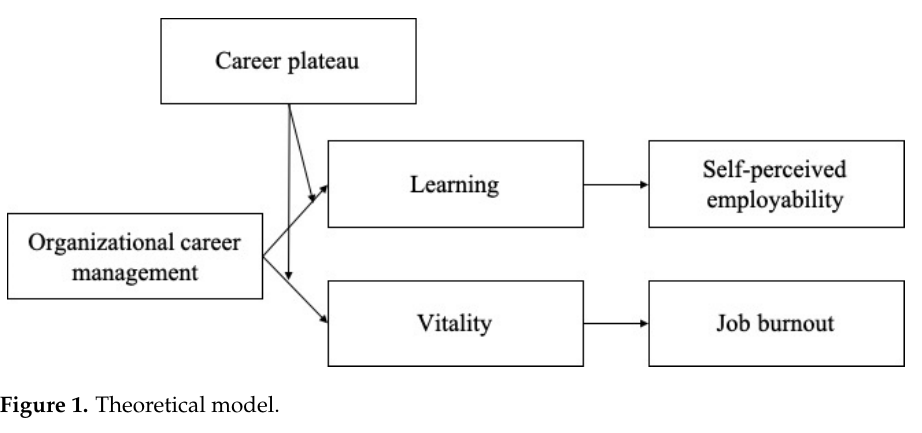
Figure 1. Theoretical model.